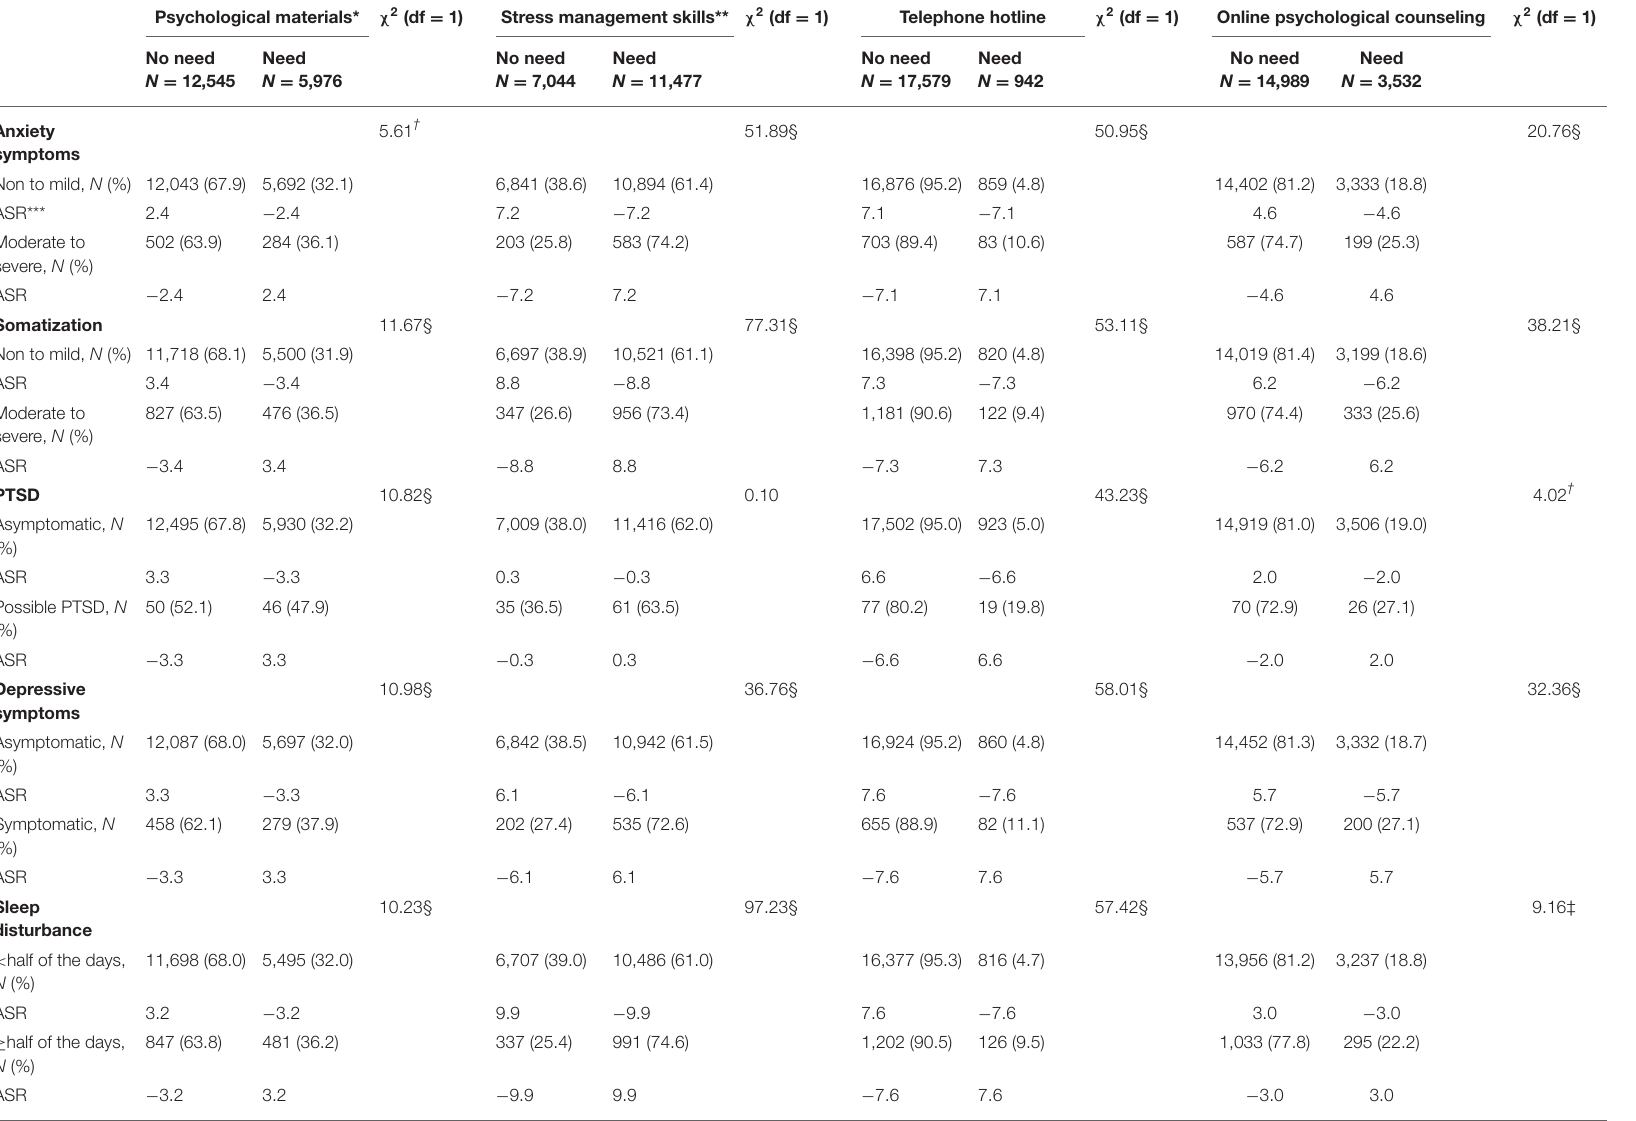
TABLE 4 | The association between Treatment preference and GAD-7, PHQ-15, PHQ-2, SI, Sleep disturbance Chi-square analysis. Psychological materials* χ 2 (df =